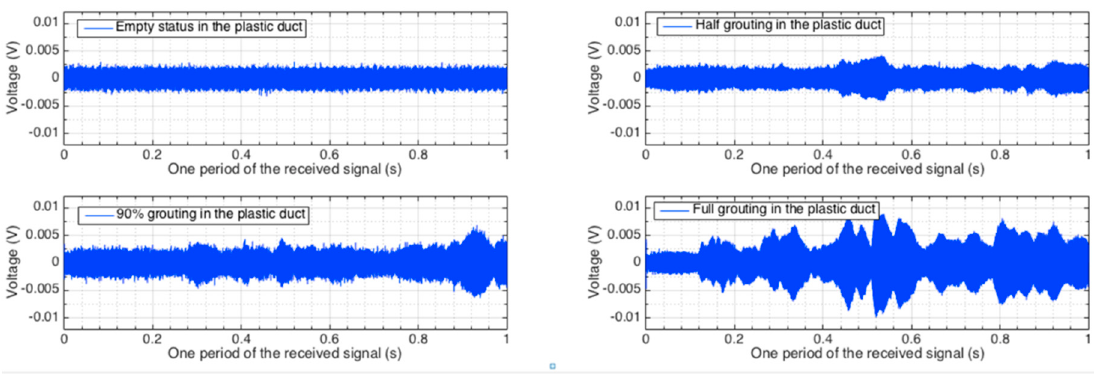
Figure 11. Time-domain signal of PZT 2 sensor in different grout stages.